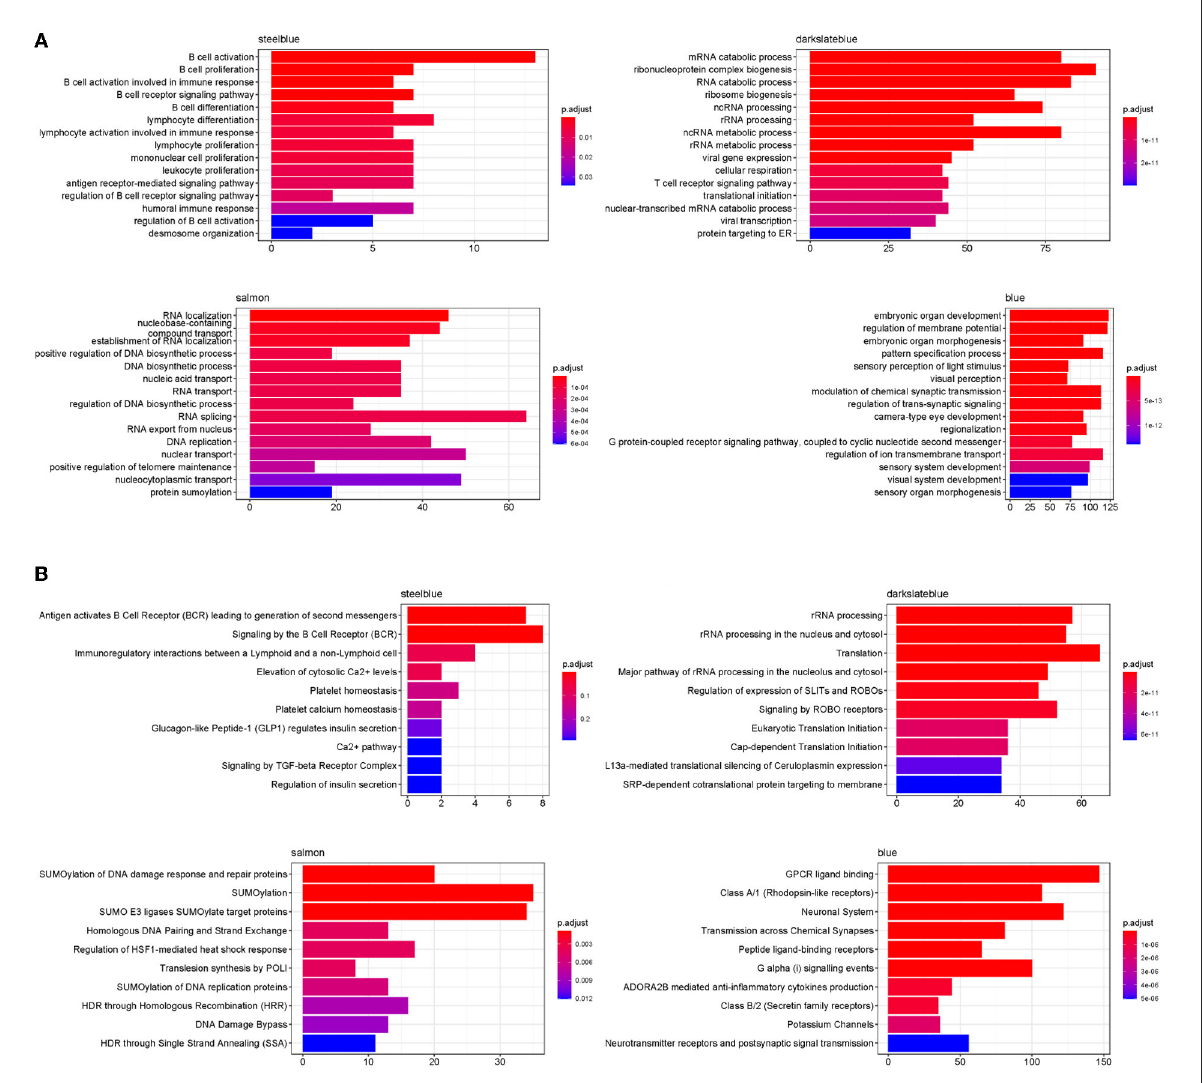
FIGURE12 Functional enriched terms in four disease modules. (A) Top 15 enriched GO terms for biological processes in four disease modules. (B) Top 10 enrichment of Reactome ontologies in four disease modules.